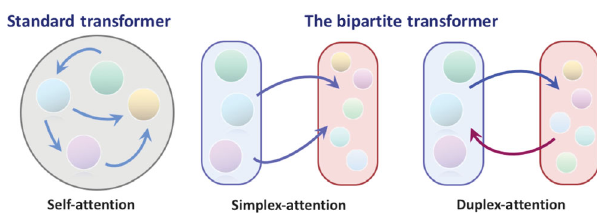
Fig. 20 Overview of the GANsformer framework. Reproduced with permission from Ref. [35], c (cid:2) The Author(s) 2021. information. Following encoding, a multilayer trans- former decoder generates the output sequences.